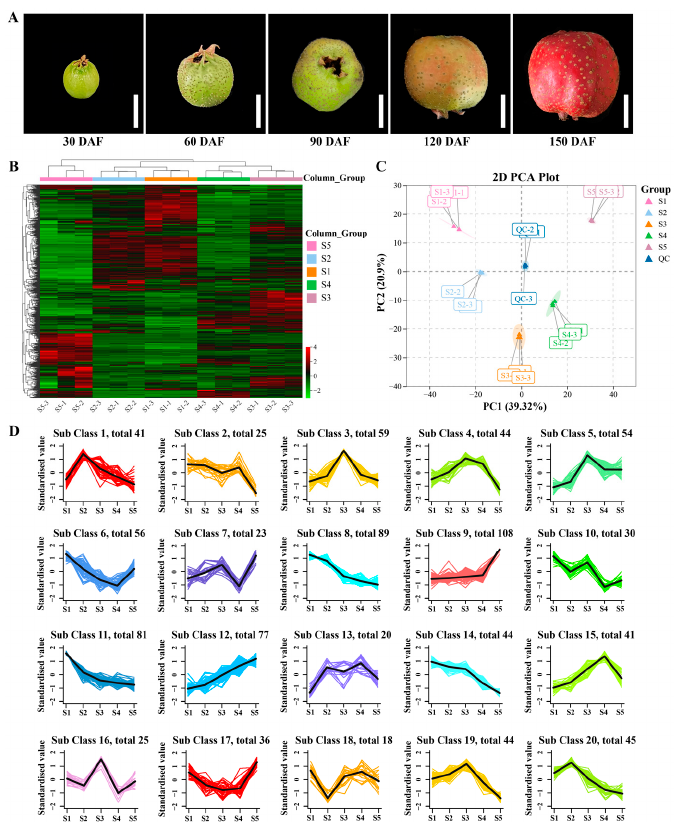
Figure 1. Dynamic metabolome of hawthorn fruit during development. ( A ) Fruit morphologies of ‘Shandong Dajinxing’ at five developmental stages; ( B ) heat map of all metabolites identified in hawthorn fruit at the five developmental stages; ( C ) principal component analysis of metabolomic data from hawthorn fruits at the five developmental stages; ( D ) cluster analysis of all 998 metabolites according to their concentration trends among the five fruit developmental stages. S1, S2, S3, S4, and S5 represent the five developmental stages of hawthorn fruit: S1, 30 days after full-bloom (DAF); S2, 60 DAF; S3, 90 DAF; S4, 120 DAF; and S5, 150 DAF.